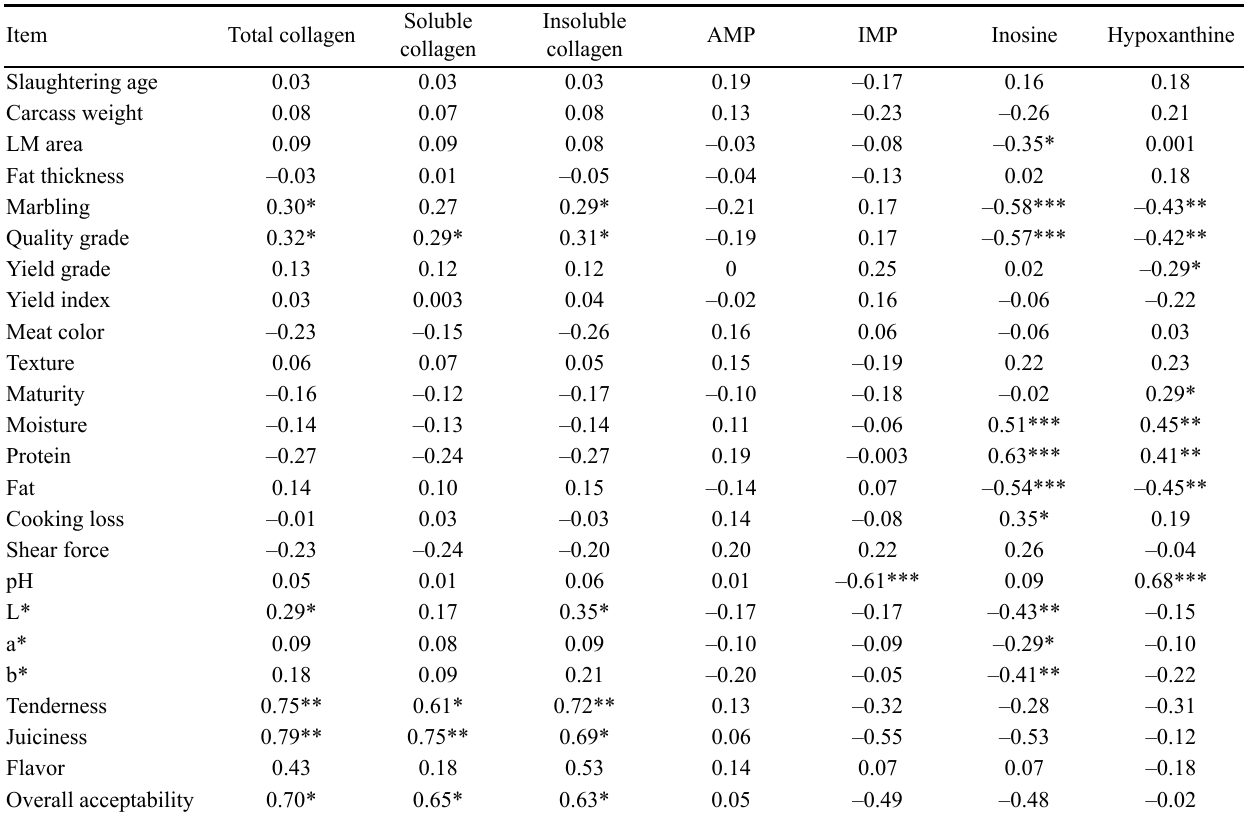
Table 11. Pearson correlation coefficient between carcass traits and chemical composition, and sensory characteristics and collagen and nucleotide contents of loin in Korean cattle steers Item Total